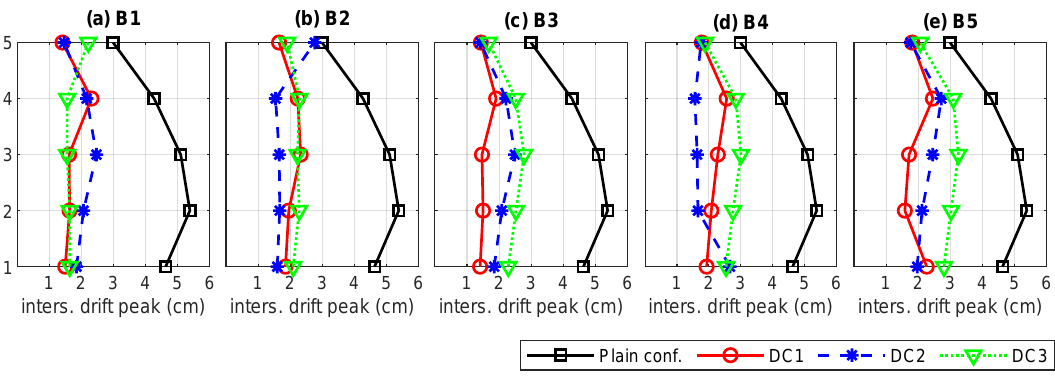
Figure 9. Maximum absolute interstory drifts corresponding to the nonactuated multibuilding system (plain configuration) and the damping configurations DC1, DC2 and DC3.